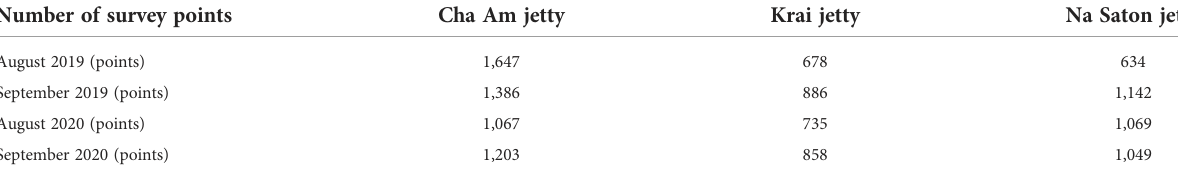
TABLE 4 Number of survey points at the updrift jetties in this study. Number of survey